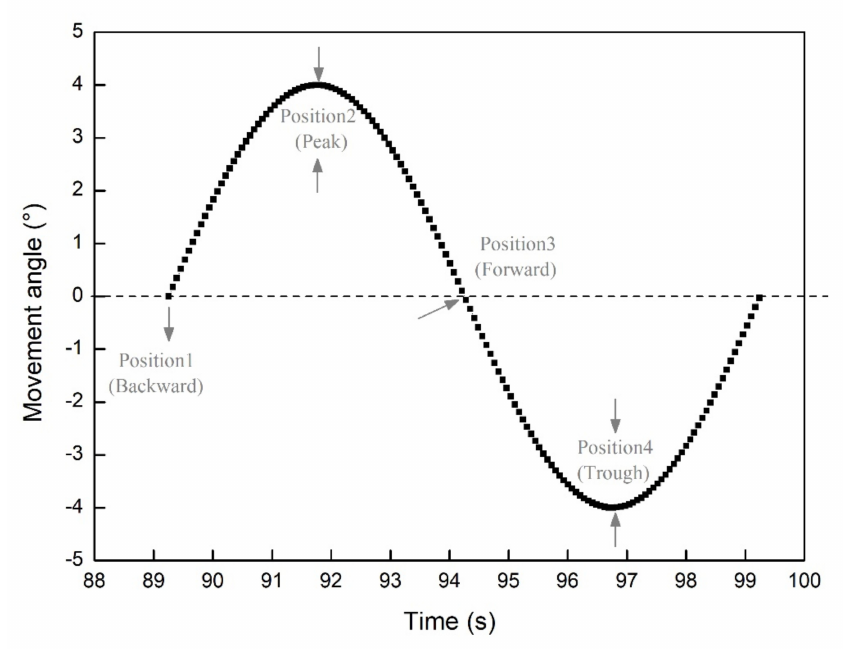
Figure 15. The different positions during the process of